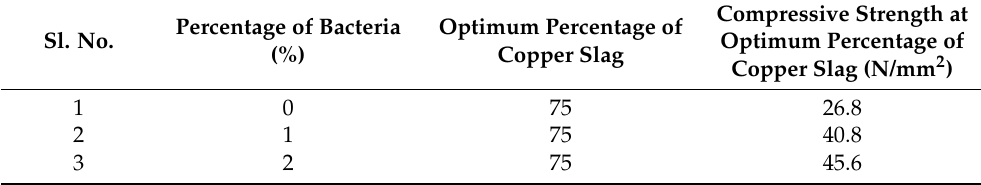
Table 9. Optimum percentage of copper slag and